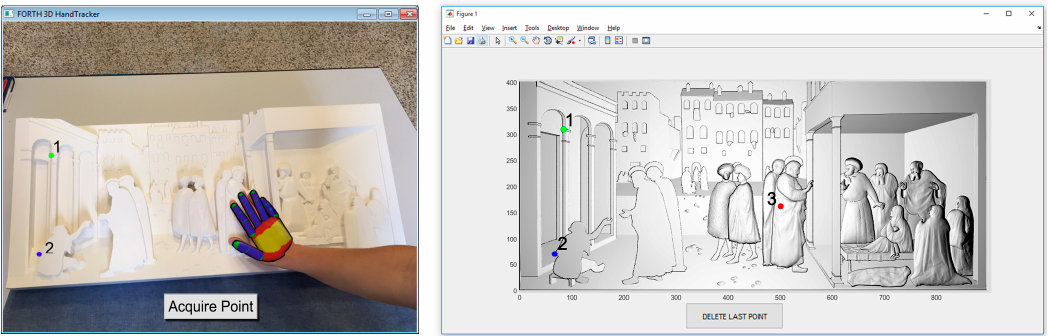
Figure 3. Custom-made coarse registration GUI.